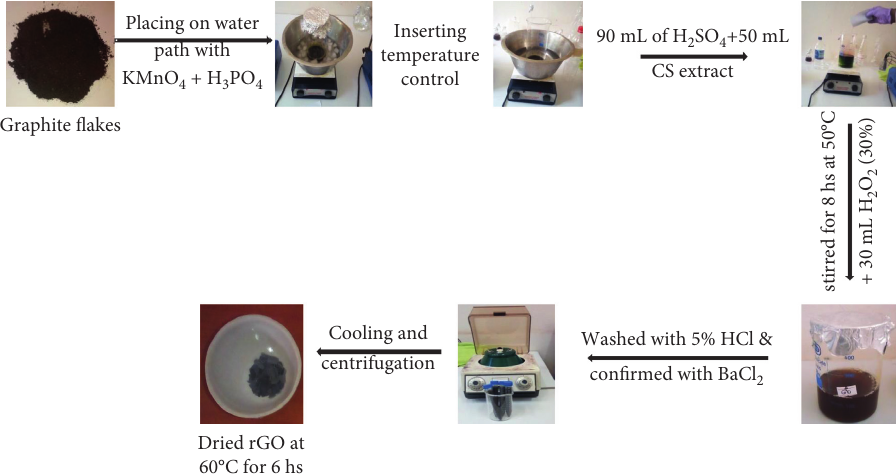
Figure 2: Diagrammatic synthesis procedure of rGO using Citrus sinensis peel